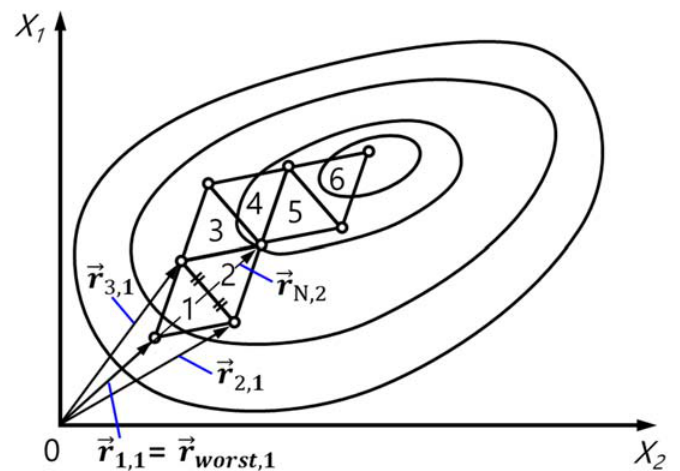
Figure 9. Geometrical interpretation of simplex strategy with two factors